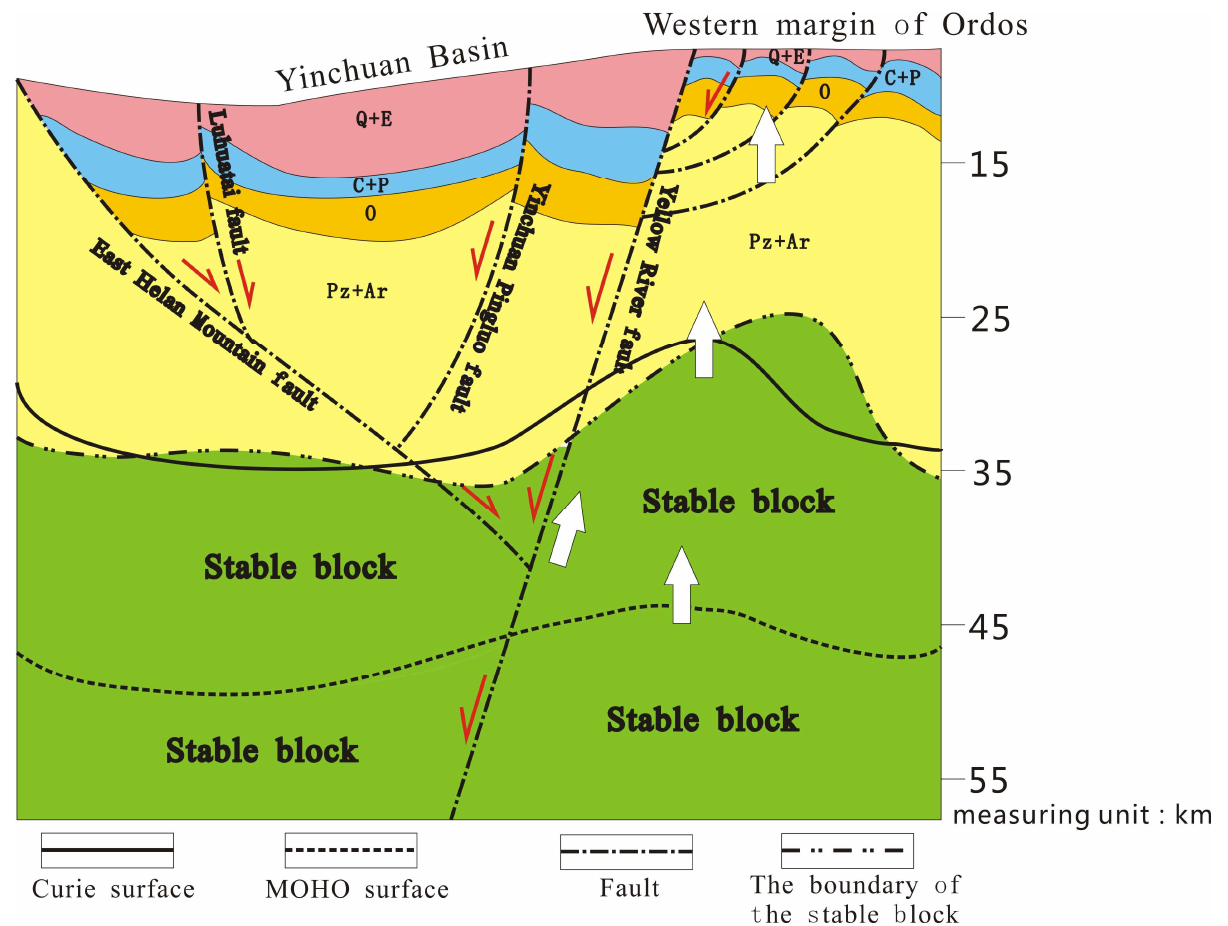
Figure 9. The deep geothermal geological model of study area. The red arrows represent the property of the faults. The white arrows represent the direction of the heat flow.